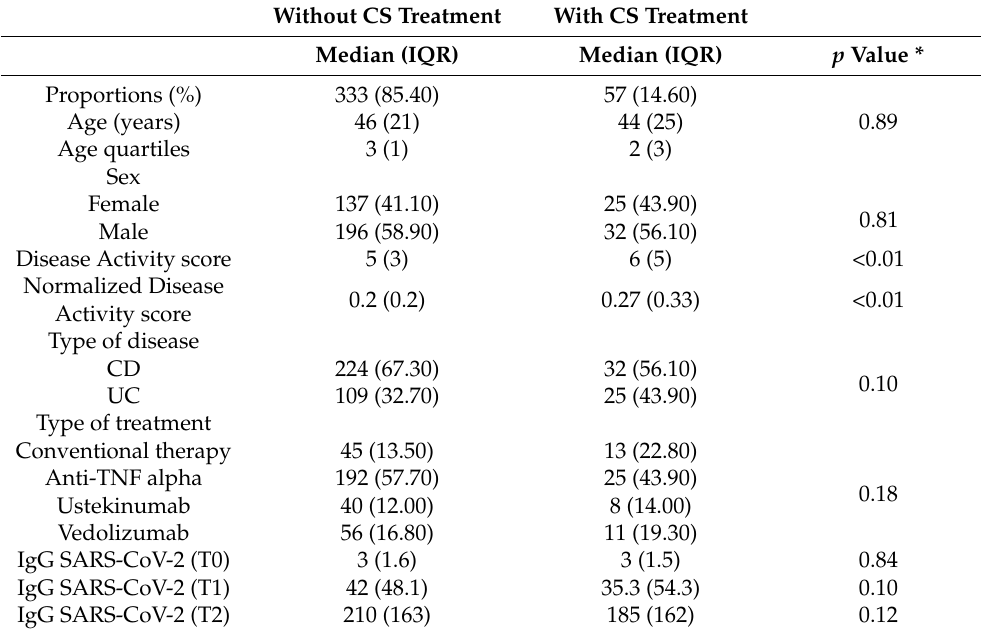
Table 2. Description of the whole sample according to CS treatments. N: 390. All data are shown as median (IQR) for continuous variables and as n (%) for proportions.